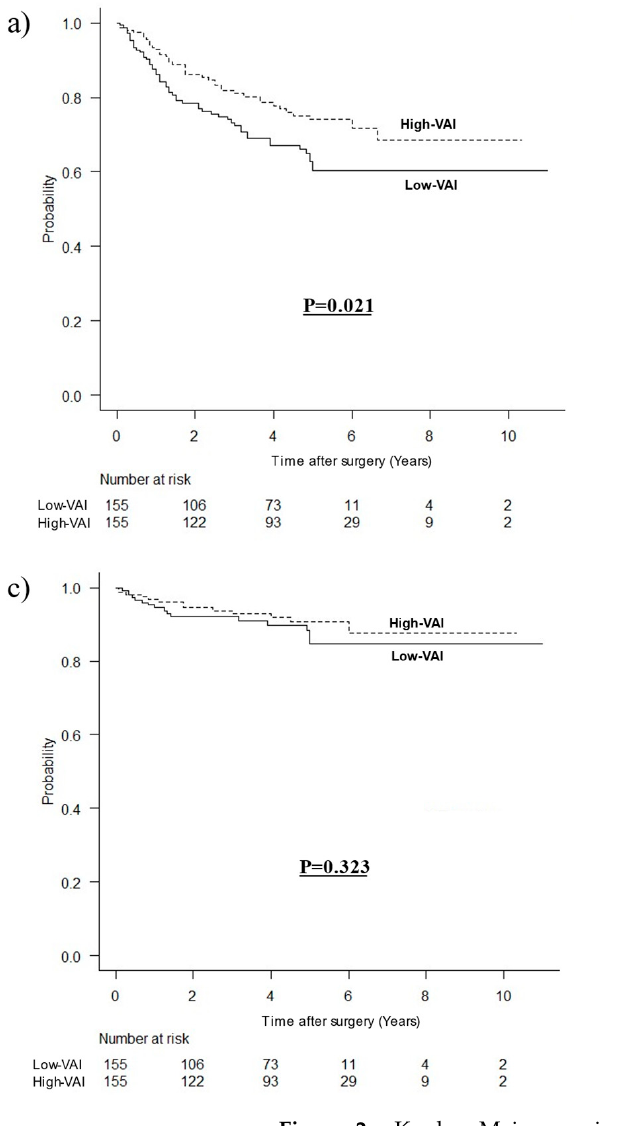
Figure 2. Kaplan–Meier survival curves according to visceral adipose tissue after matching. ( a ) For overall survival, ( b ) for cancer-specific survival, ( c ) for other-cause survival, ( d ) for disease-free survival.